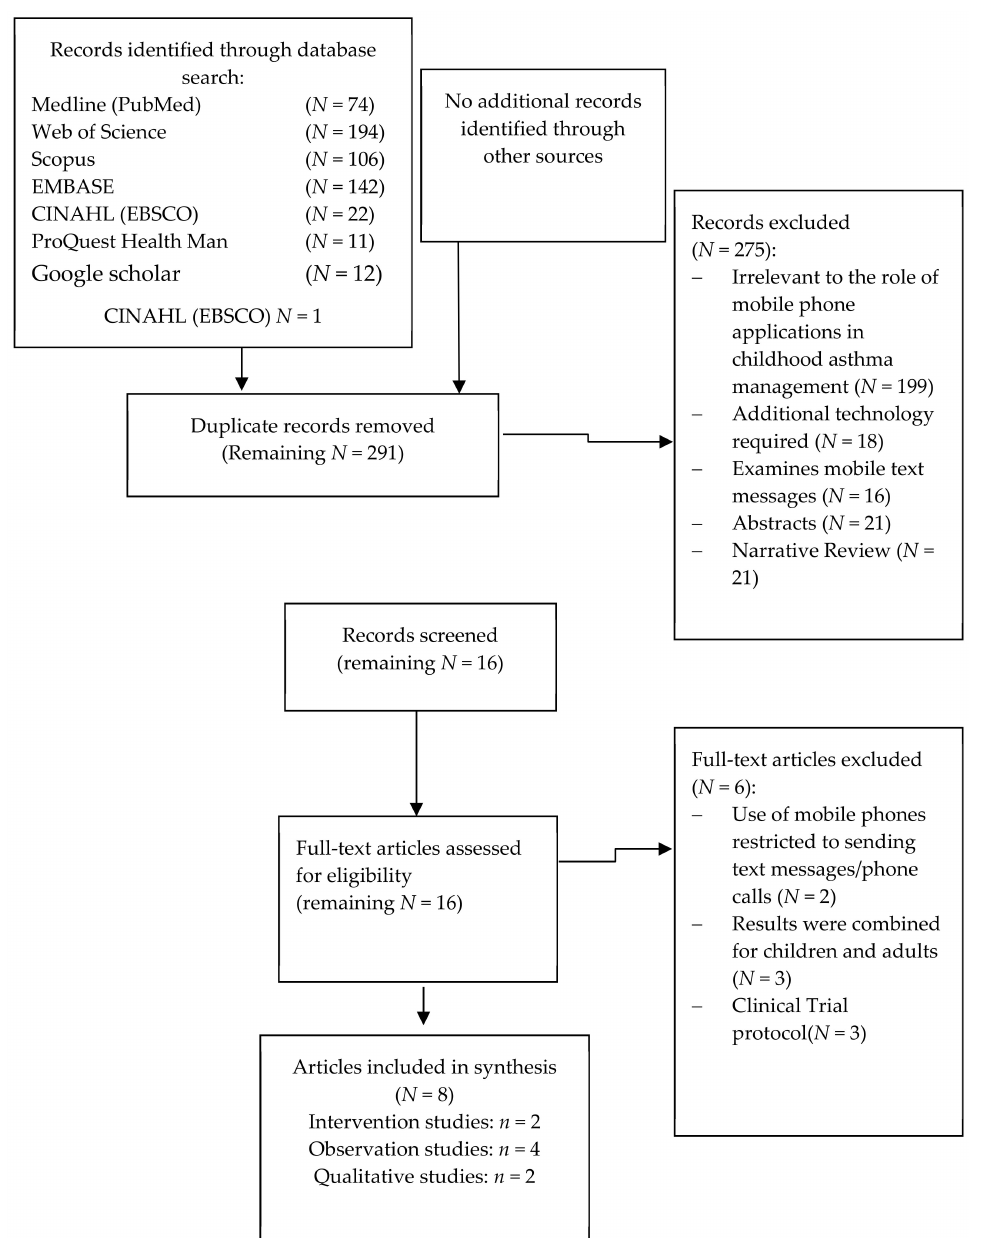
Figure 1. Preferred Reporting Items for Systematic Reviews and Meta-Analysis (PRISMA) flow chart of search